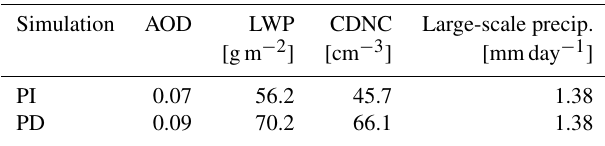
Table 1. AOD, LWP, CDNC and large-scale precipitation averaged over the whole of the North Pacific (same area as shown in Fig. 2) for the winter